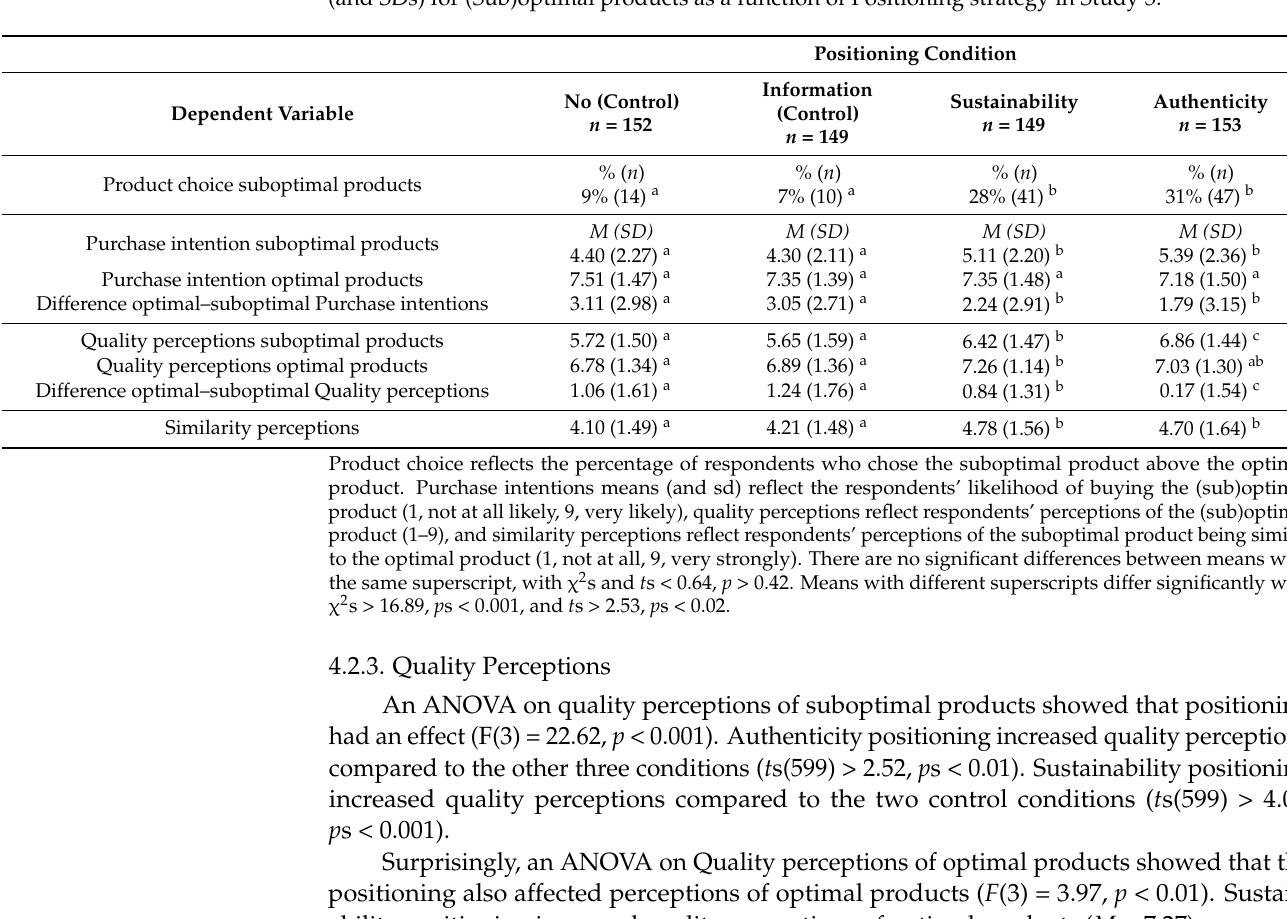
Table 2. Product choice, Purchase intentions, Quality perceptions, and Similarity perceptions Means (and SDs) for (Sub)optimal products as a function of Positioning strategy in Study